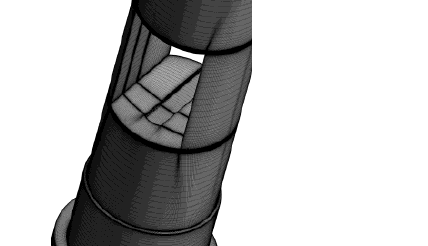
Fig. 4. Surface mesh detail of the extinction probe